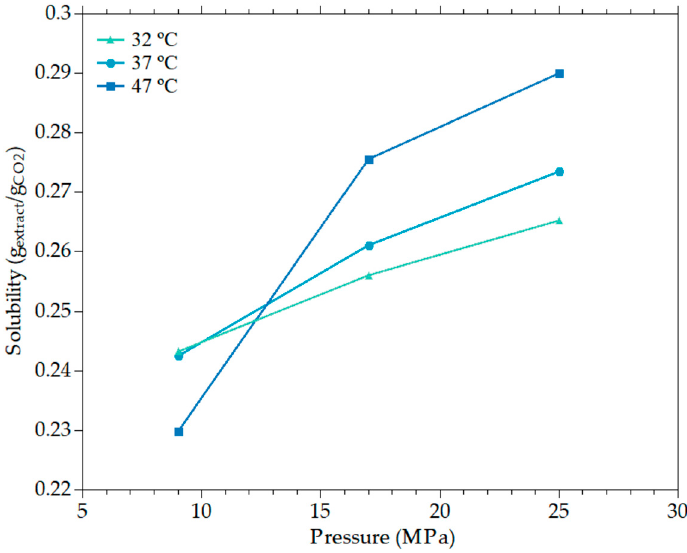
Figure 5. Solubility of clove extract in scCO 2